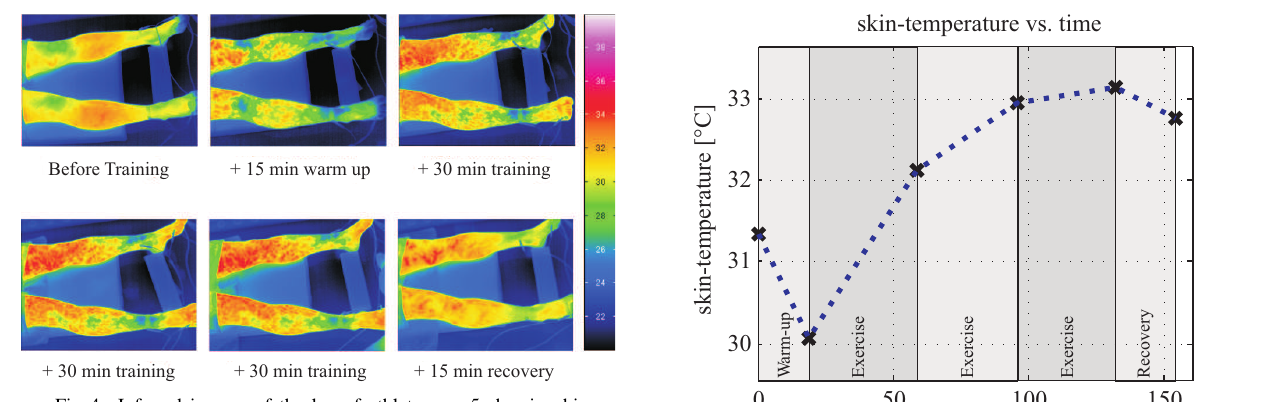
Fig.4: Infrared images of the leg of athlete no. 5 showing his temperature profile during the trial.